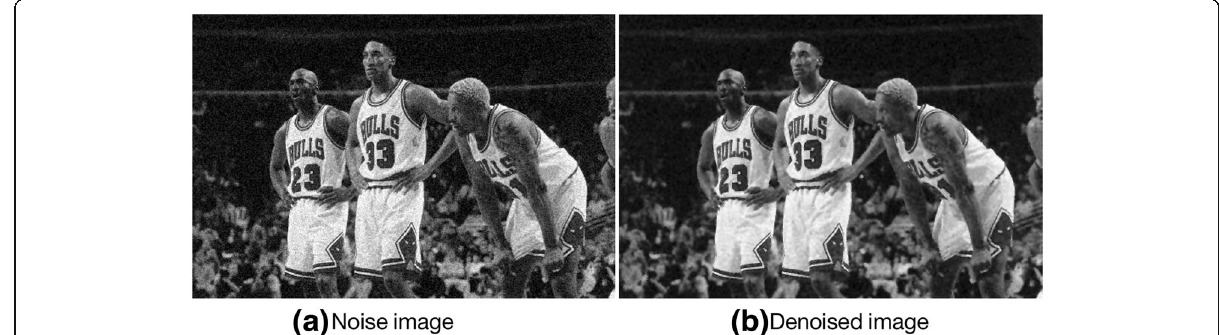
Fig. 4 Image denoising processing. a Noise image. b Denoised